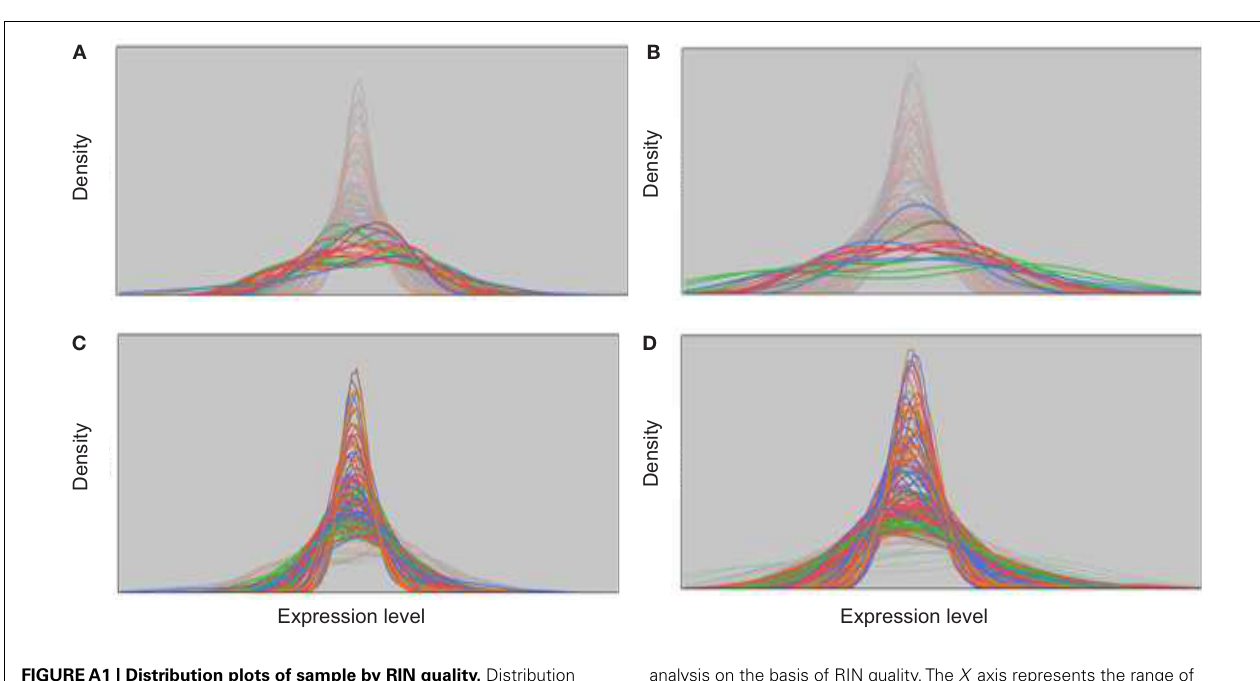
FIGUREA1 | Distribution plots of sample by RIN quality. Distribution plots of Fluidigm Experiments I (A,C) and II (B,D) highlighting the samples that were excluded (A,B) or included (C,D) for downstream